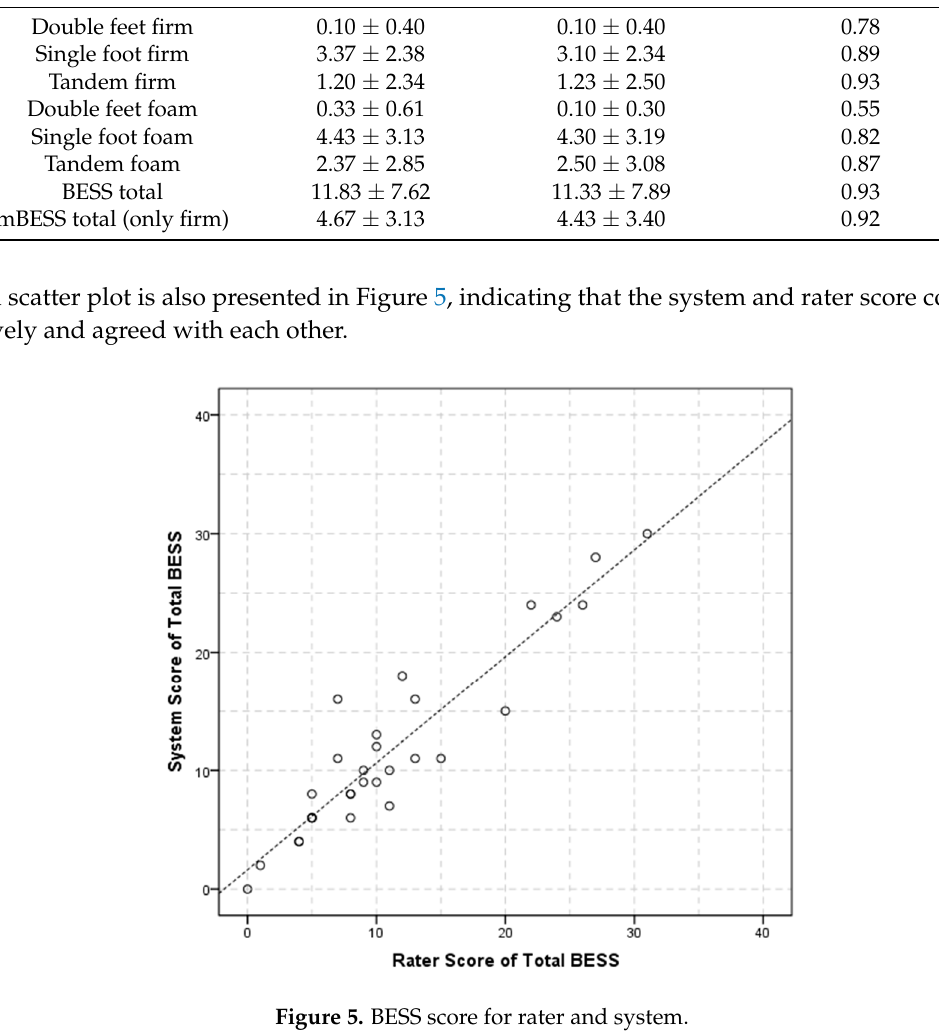
Figure 5. BESS score for rater and system.